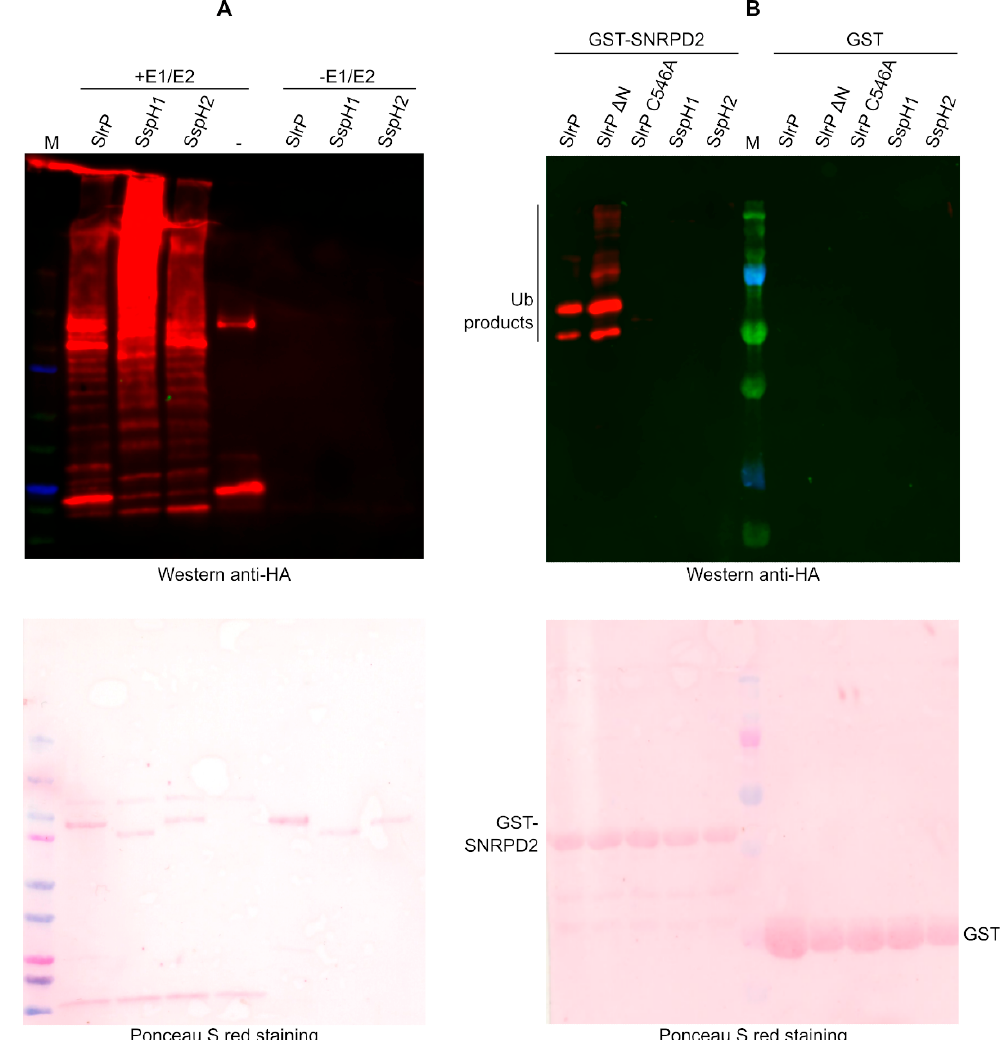
Figure 5 . Specificity of the ubiquitination of SNRPD2. ( A ) The activity of 6His-tagged SlrP, SspH1 and SspH2 was tested with HA-ubiquitin in the presence or in the absence of E1, and E2. SlrP: 6His-SlrP, SspH1: 6His-SspH1, SspH2: 6His-SspH2, -: no E3 ligase effector added. ( B ) Ubiquitina- tion of GST-SNRPD2 bound to glutathione-agarose beads was tested in the presence of HA-ubiquitin, E1, E2, and a Salmonella effector fused to 6His: wild-type SlrP, SlrP ∆ N (lacking 139 N-terminal residues), SlrP C546A mutant, wild-type SspH1 or wild-type SspH2. GST was used as negative control. Beads were washed before the immunoblot analysis. Ponceau S red staining is shown in the lower panel. M, molecular weight markers (size of bands in kDa: 250, 150, 100, 75, 50, 37, 25, 20).